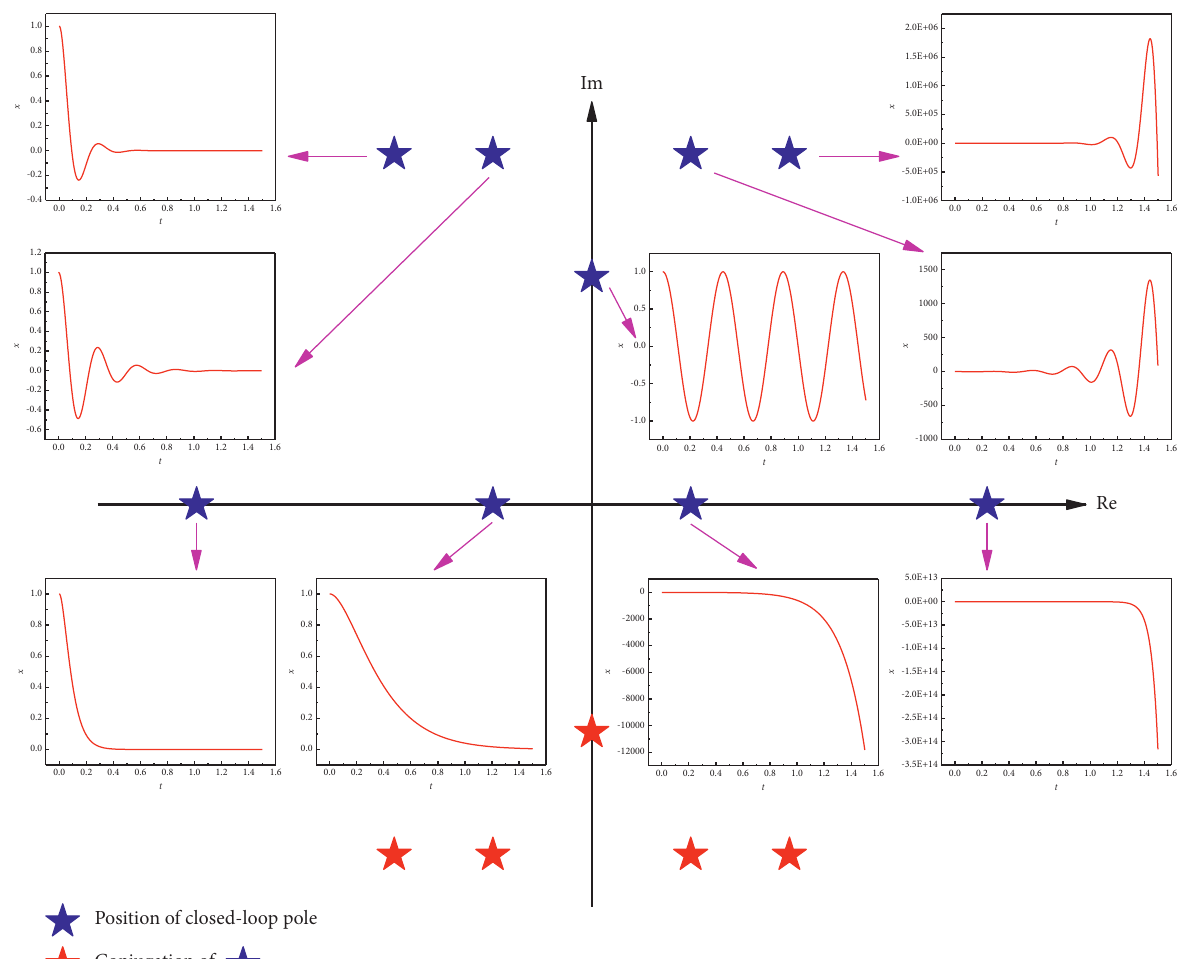
Figure 2: Closed-loop poles distribution and motion form of transient